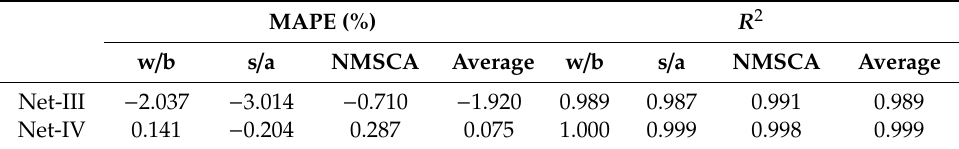
Figure 7. Identified: ( a ) w / b, ( b ) s / a, ( c ) NMSCA values of each testing image calculated with the outputs of Net-III and identified ( d ) w / b, ( e ) s / a, ( f ) NMSCA values of each testing image calculated with the outputs of Net-IV. Table 16. MAPE and R 2 of each label and two network